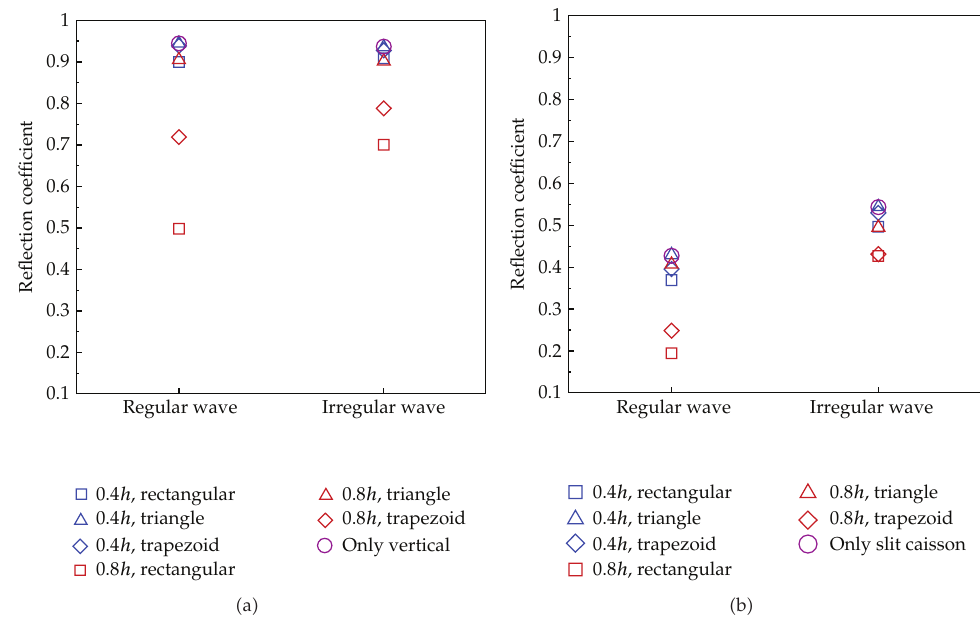
Figure 2: Reflection coe ffi cients of the regular and irregular